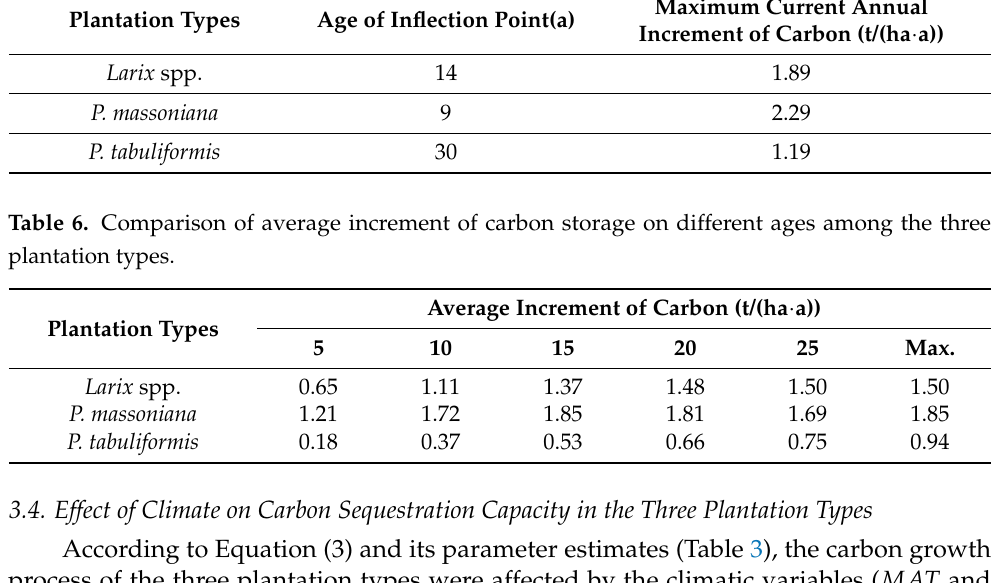
three plantation types.